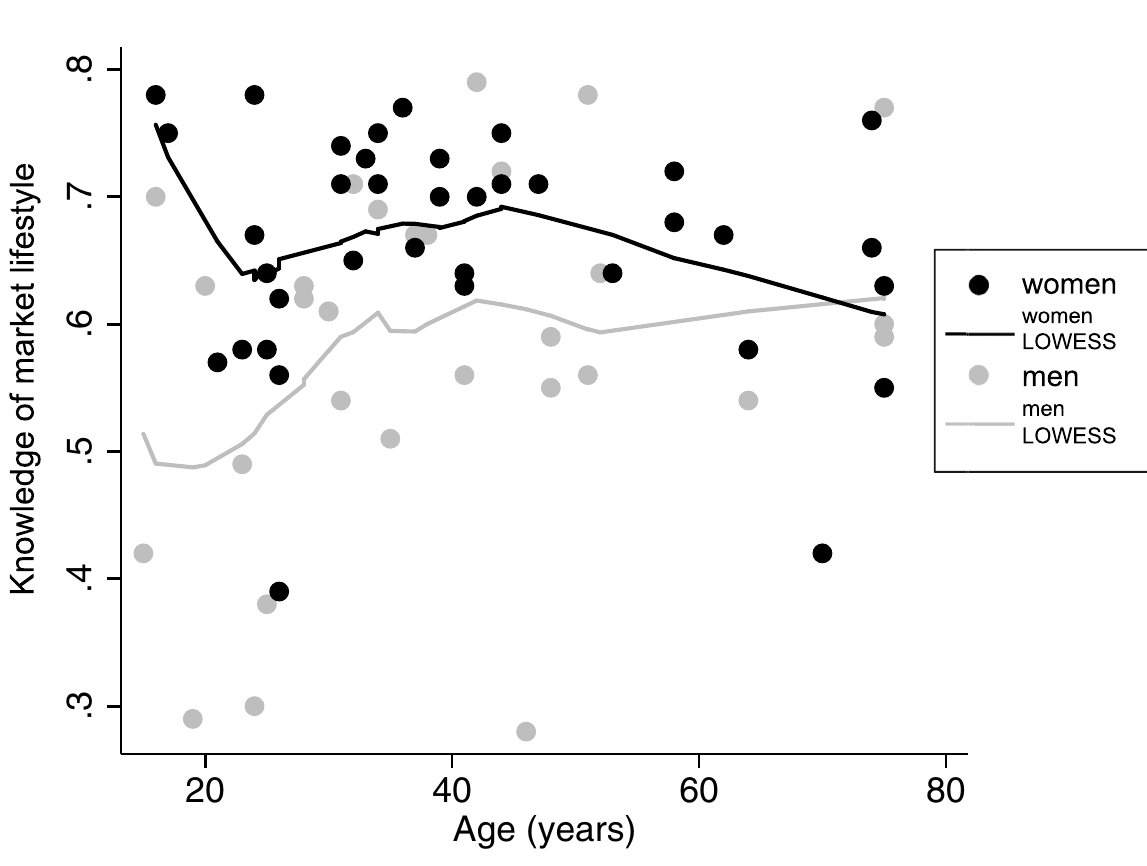
Fig 4. Nonparametric LOWESS of lifestyle knowledge by respondent gender and age.